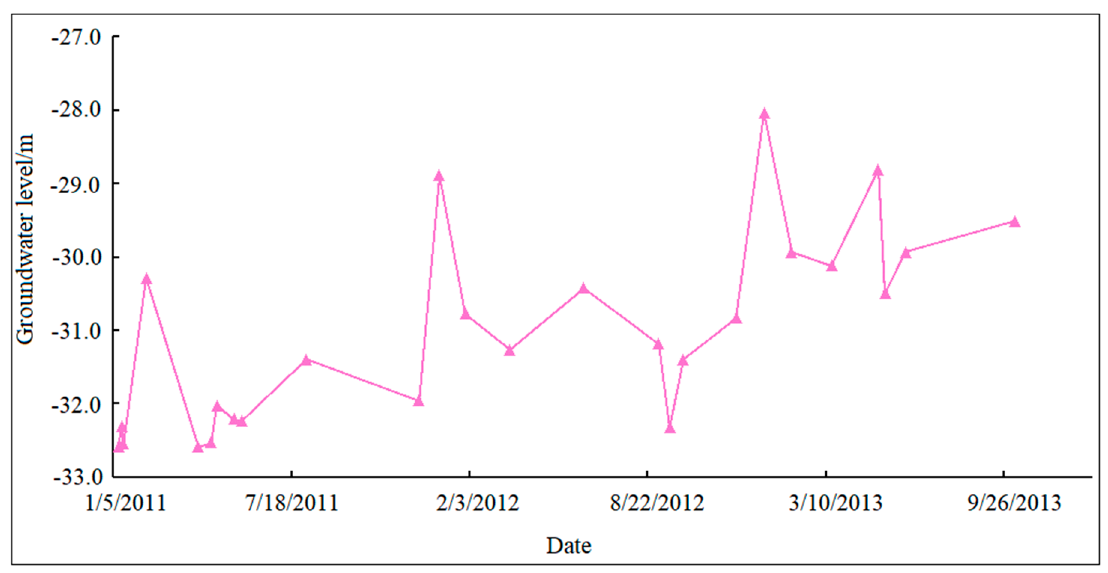
Figure 6. Dynamic variation of groundwater level in the third confined aquifer.